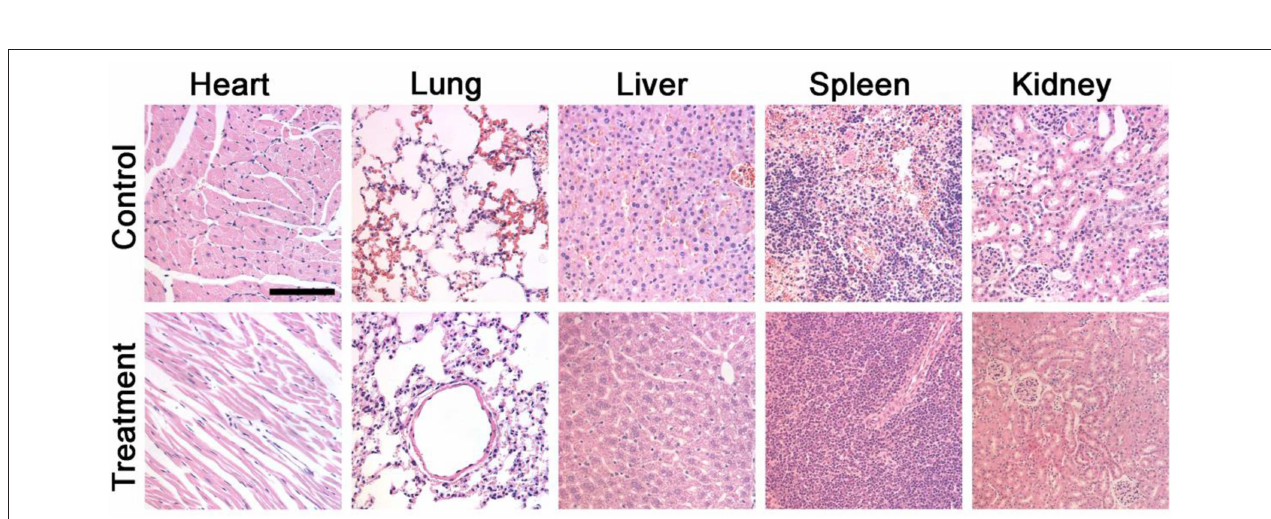
FIGURE 6 | Hematoxylin- and Eosin-stained tissue sections from the two groups of mice to evaluate the histological changes in heart, lung, liver, spleen, and kidney of the mice one month after a single intravenous injection of CMO NC solution. Scale bar: 100 µ m.